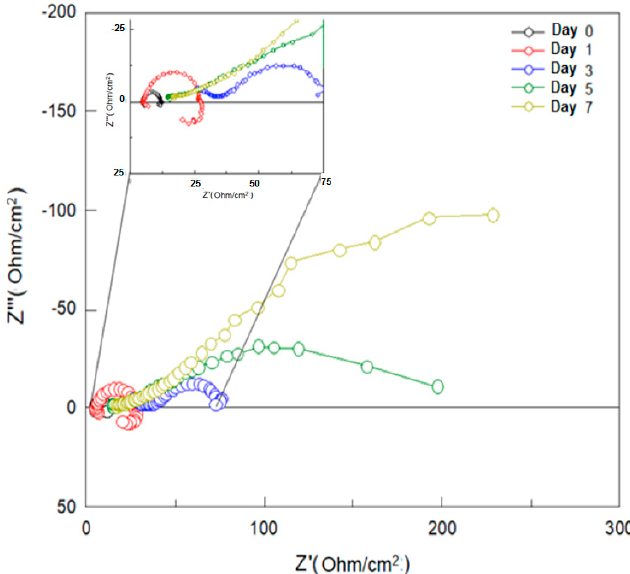
Figure 11. Nyquist diagrams for Mg ‐ 1Nb anode for 0, 1, 3, 5, and 7 days of immersion in seawater.